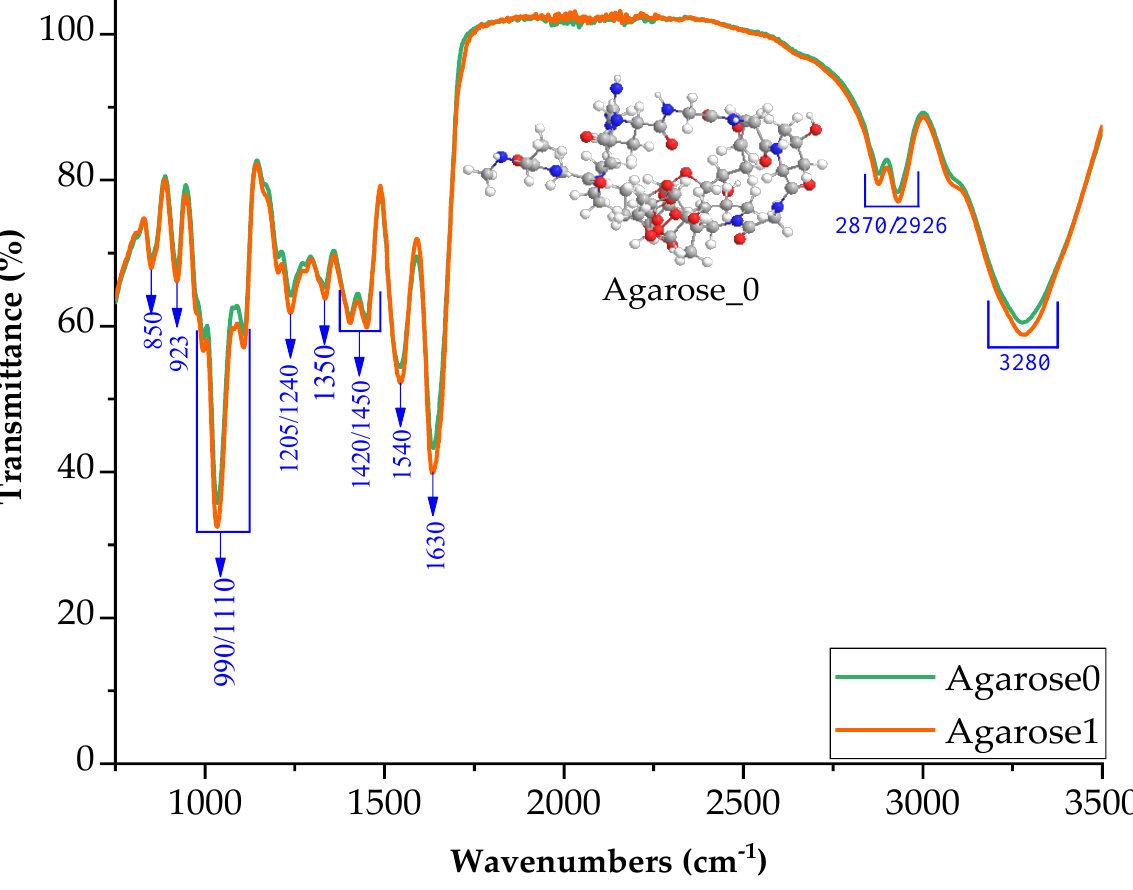
Figure 3. FTIR spectra of samples with agarose additive in neutral and basic pH (1M NaOH). The introduction of the active base into agarose could cause breakage of the bond be- tween the hydrogen and oxygen, therefore creating electronegative oxygen that potentially partakes in reactions and generates ionic